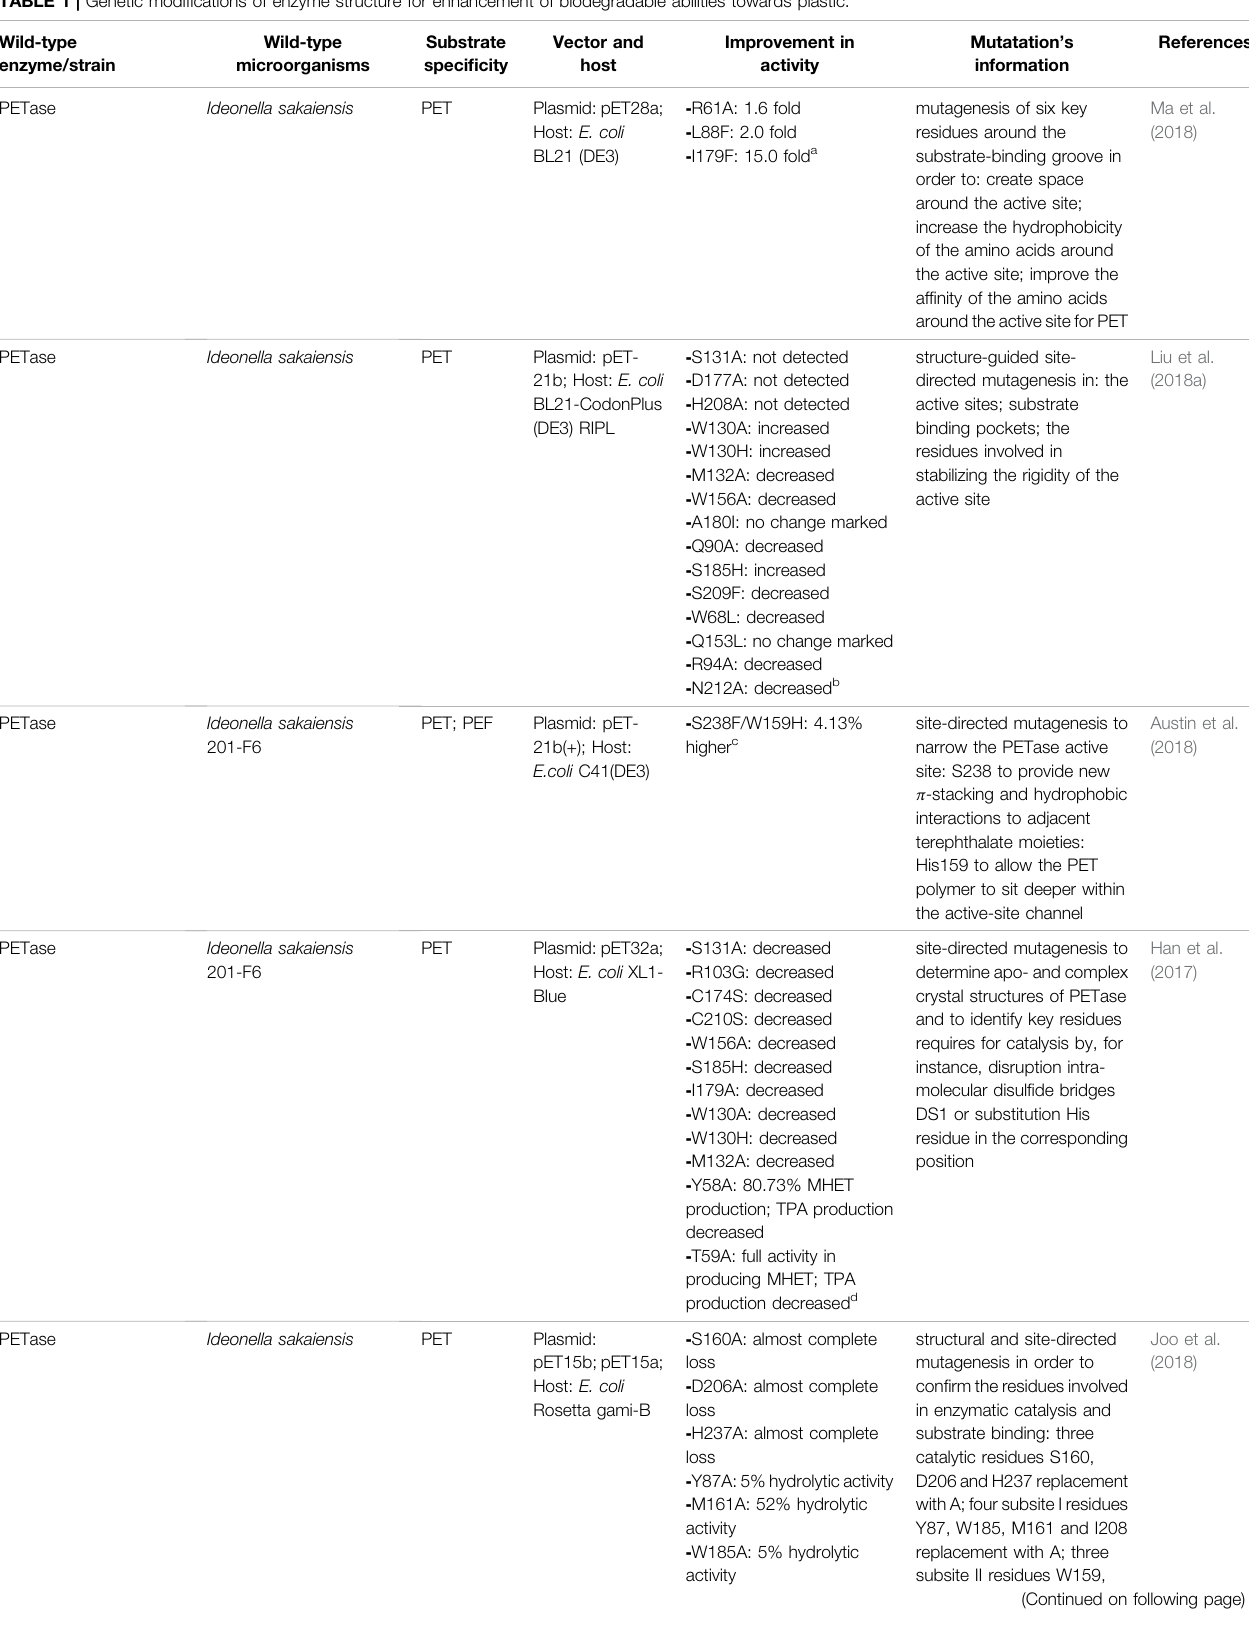
TABLE 1 | Genetic modi fi cations of enzyme structure for enhancement of biodegradable abilities towards plastic. Wild-type